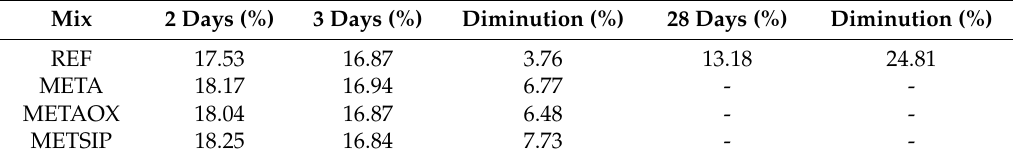
Table 4. Results from mercury intrusion porosimetry at di ff erent